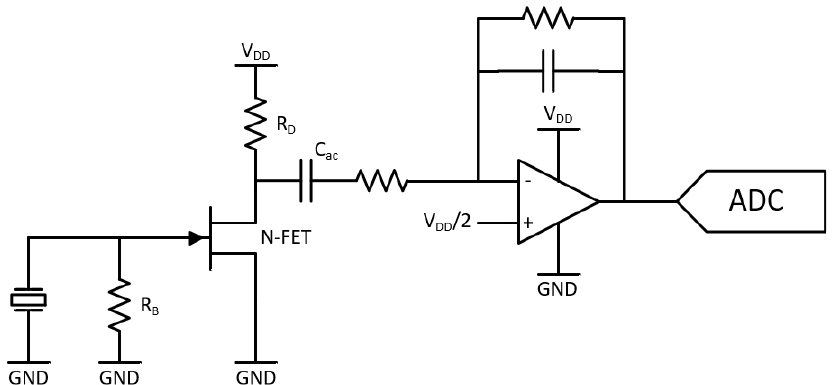
Figure 3. Simplified schematic of the sound acquisition module composed of impedance converter, gain and filtering stage, and analog-to-digital converter.